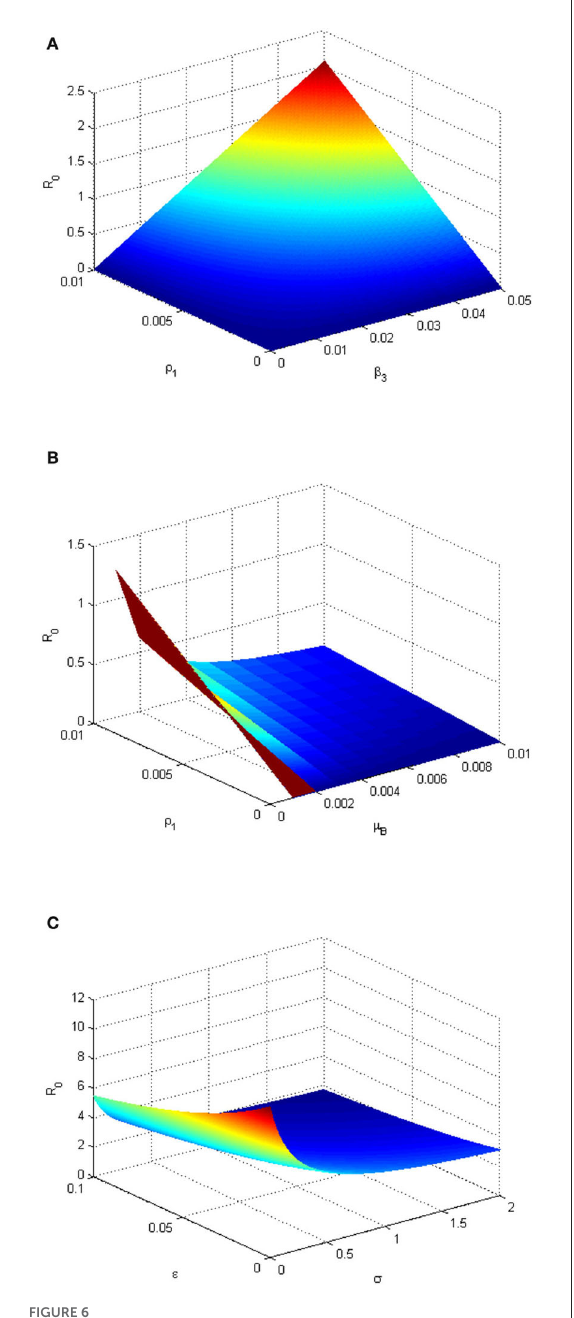
FIGURE6 (A) Three-dimensional plot depicting the relationship between R 0 H and environmental transmission rate ( β 3 ), infected human shedding rate ( ρ 1 ), and R 0 H . The plot shows the sensitivity of the R 0 H to the changes (variation) of the parameters β 3 and ρ 1 . (B) Three-dimensional plot depicting the relationship between the decay rate of MPXV in the environment ( µ B ), ρ 1 and R 0 H . The graph shows the sensitivity of the R 0 H to the changes (variation) of the parameters µ B and ρ . (C) Three-dimensional plot depicting the relationship between quarantine rate ( σ ), ǫ , and R 0 H . The graph shows the sensitivity of the R 0 H to the changes (variation) of the parameters σ and ǫ . The parameter values used are given in Table